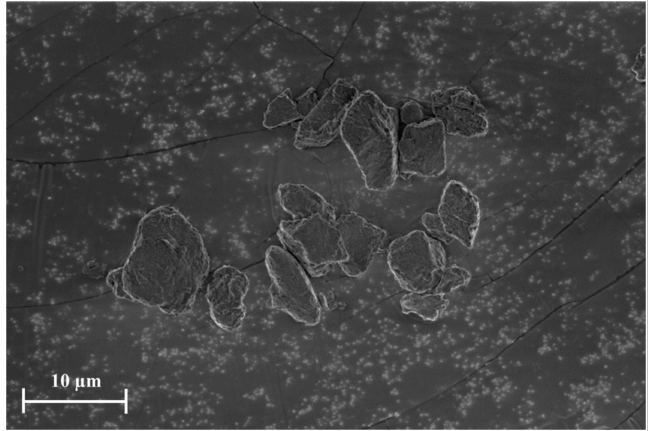
Figure 3. Scanning electron microscope (SEM) image of standard particles.